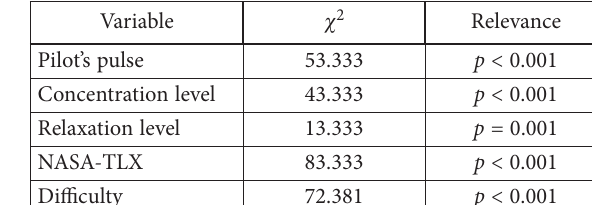
Figure 3. The distribution of the “Pulse” variable